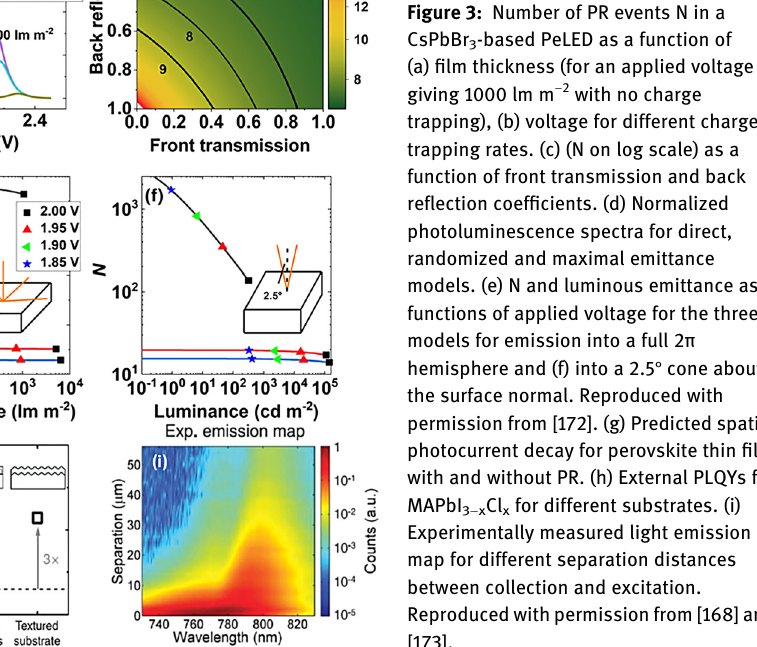
distinctly trace scattered photons versus recycled photons at a fi nite distance from the excitation point by marking the corresponding redshifts [151]. Through this, PR was shown to account for 55% of the total luminance intensity. Localized excitation giving rise to light output at a distance was also observed when further applied to a PeLED, which reinforces the proposed dependence of PR on device geometry (lateral and vertical). On a slightly different note, optically thick MAPbX bulk single crystals were studied, 3 and their signi fi cant PL redshift as compared to their thin- fi lm counterparts was attributed to PR events [178]. It was also shown that the dependence of PL peak energy on the grain size in polycrystalline thin fi lms is explainable by considering intra- and inter-grain PR events along with the spatial distribution of excited carriers.